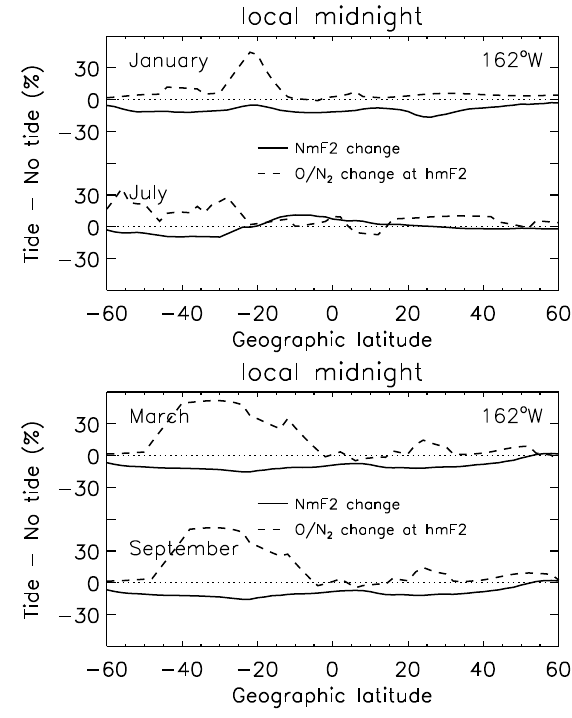
Fig. 6. Effect of mesospheric tides on values of asymmetry in- dex, as percentage of non-tide values. Above: Solstices, Below: Equinoxes. Full curves: Peak electron density. Dashed curves: Neutral O/N 2 ratio at the height of the F2-peak. All curves are for local noon.